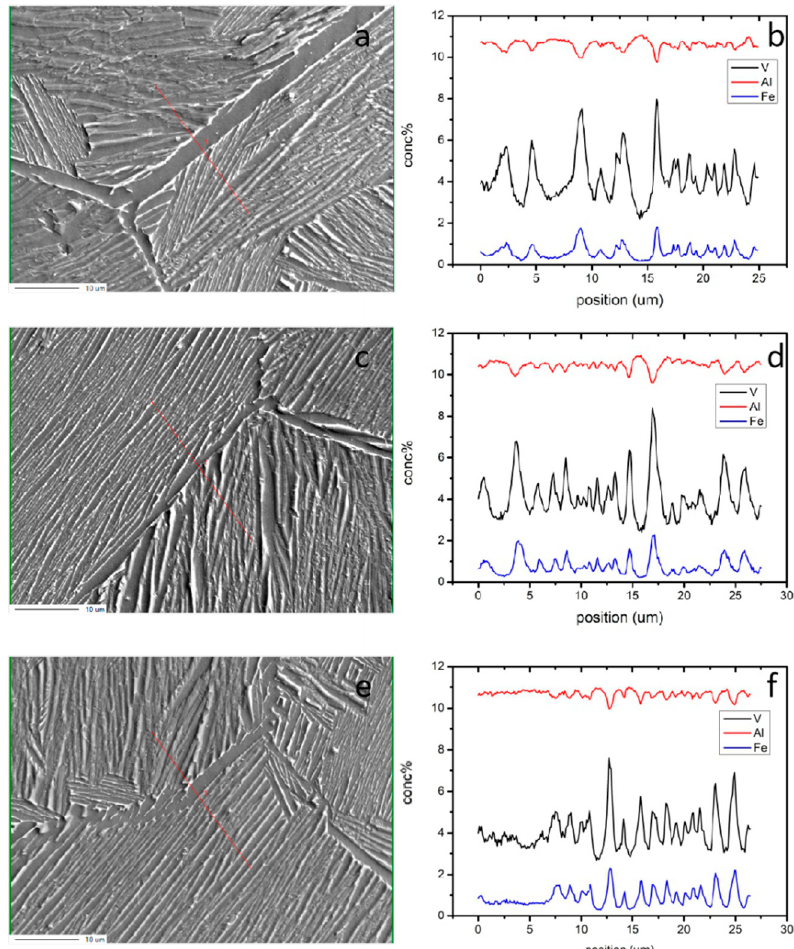
Figure 13. Results of the EPMA line scan. ( a ) Selected location of Ti–6Al–4V–0.5Fe, ( b ) Composition distribution of Ti–6Al–4V–0.5Fe, ( c ) Selected location of Ti–6Al–4V–0.7Fe, ( d ) Composition distribution of Ti–6Al–4V–0.7Fe, ( e ) Selected location of Ti–6Al–4V–0.9Fe, ( f ) Composition distribution of